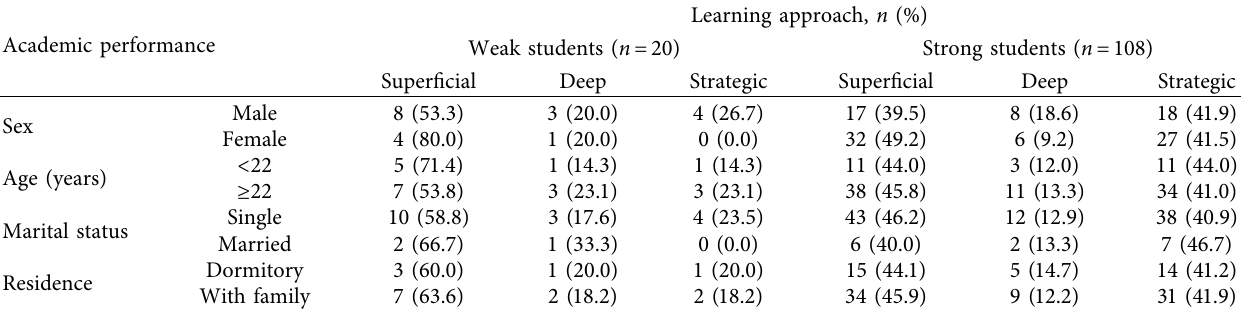
Table 4: The mean scores of learning approaches in strong and weak students in terms of demographic variables ( n � 128). Academic performance